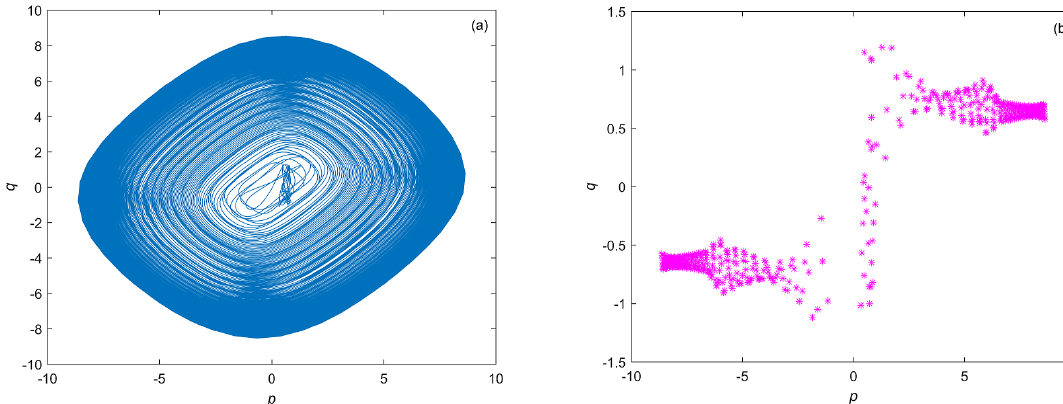
Figure 3. ( a ) The chaotic attractor in the p - q plane; ( b ) The Poincaré mapping on the section u =